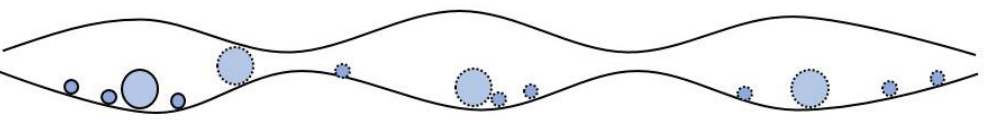
Figure 9. Schematic diagram of effect of fine particle migration on permeability (solid circles represent mineral and fine particles; dashed circles represent moving fine particles).